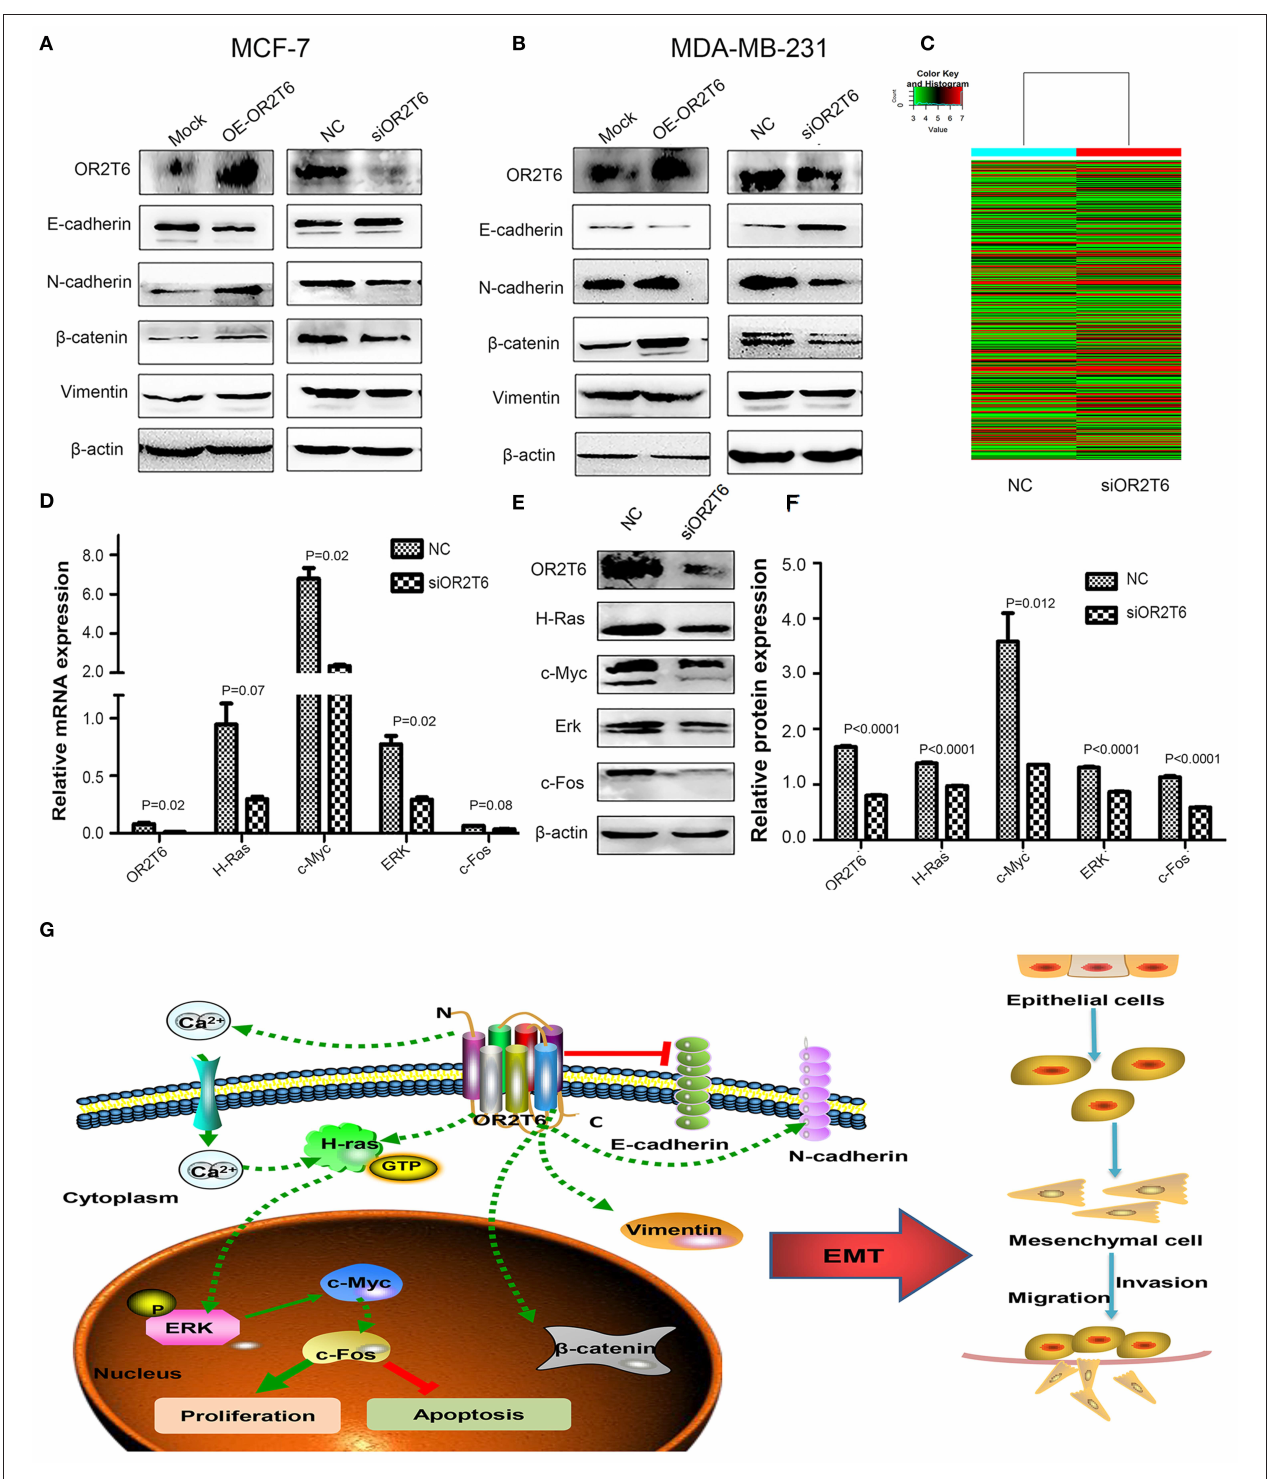
FIGURE 5 | OR2T6 plays a role in the regulation of the EMT process and the MAPK/ERK pathway in breast cancer cells. (A,B) OR2T6 promotes the initiation of the EMT in breast cancer cells. The overexpression of OR2T6 reduced the expression of E-cadherin while increased those of N-cadherin, β -catenin, and vimentin in MCF-7 (A) and MDA-MB-231 cells (B) . When OR2T6 was knocked down, the opposite results were observed (A,B) . β -actin was used as the loading control. (C) Hierarchical clustering of MCF-7 cells transfected with negative control siRNA (NC) and specific siRNA targeting OR2T6 (siOR2T6) on the basis of differentially expressed mRNAs. Each row represents the expression level of an individual mRNA. Pseudo-colors indicate expression levels from low to high (green to red).